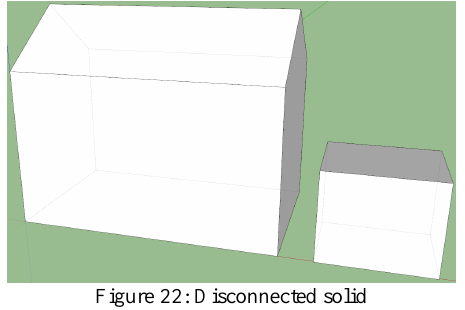
Figure 22: Disconnected solid